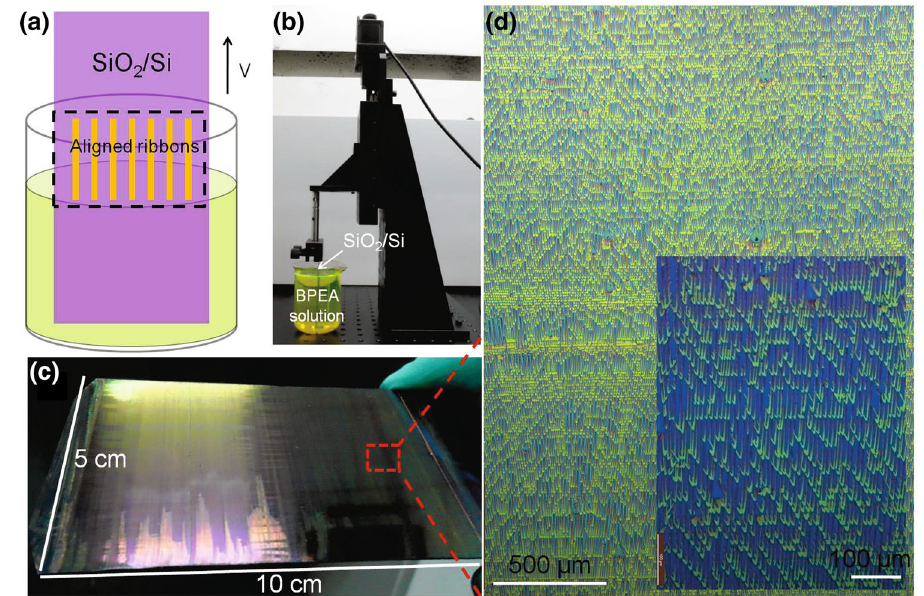
Fig. 1 Fabrication of large-area, single-crystalline organic nanoribbon arrays. a Schematic illustration of the procedure to fabricate BPEA nanoribbon arrays on the SiO 2 /Si substrate using dip-coating method. b Photograph of the dip-coating equipment. c 5 9 10 cm 2 SiO 2 /Si substrate coated with BPEA nanoribbon arrays. d Optical microscope image of the large-area BPEA nanoribbon arrays on SiO 2 /Si substrate. Inset shows the corresponding enlarged optical microscope image